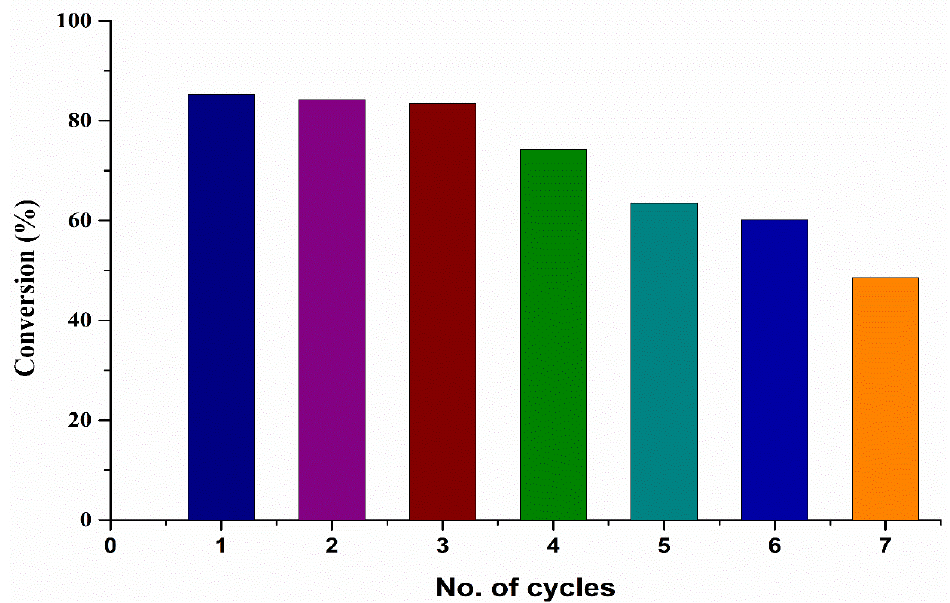
Figure 9. Reusability of the catalyst in the current microbubble